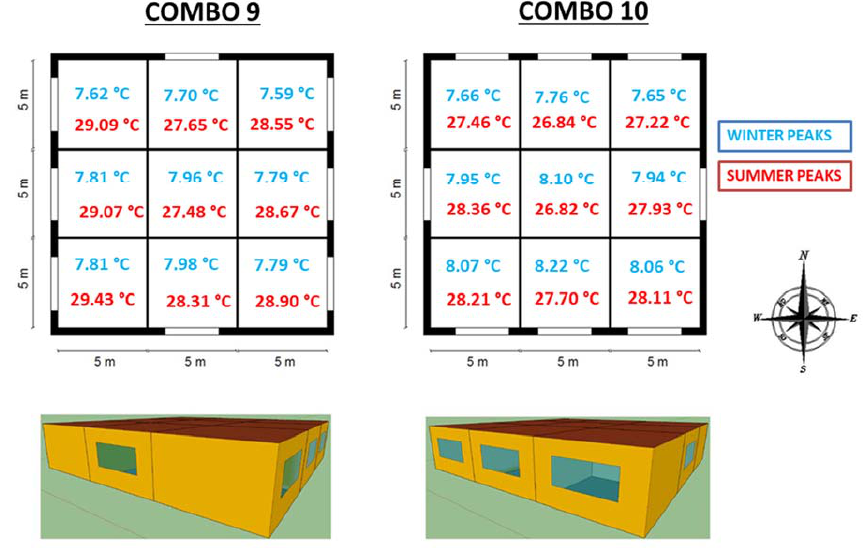
Figure 10. Winter and Summer peaks of Combo 9 and Combo 10 (from the Tables 10 and 11).